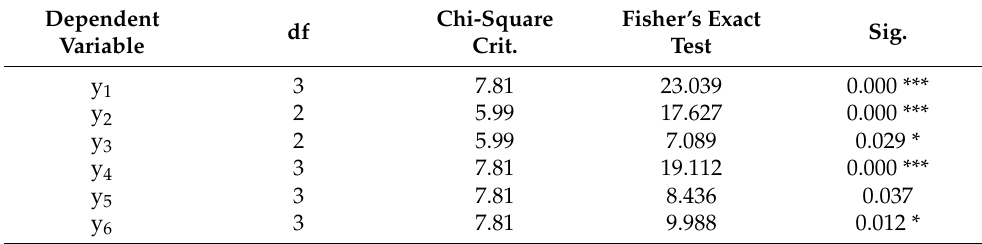
Table 5. Fisher’s exact test values depending on the supply chain rank, data for the whole sample.